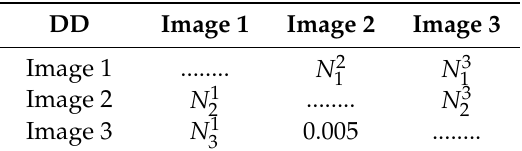
Table 2. The difference between each corresponding relative rotation